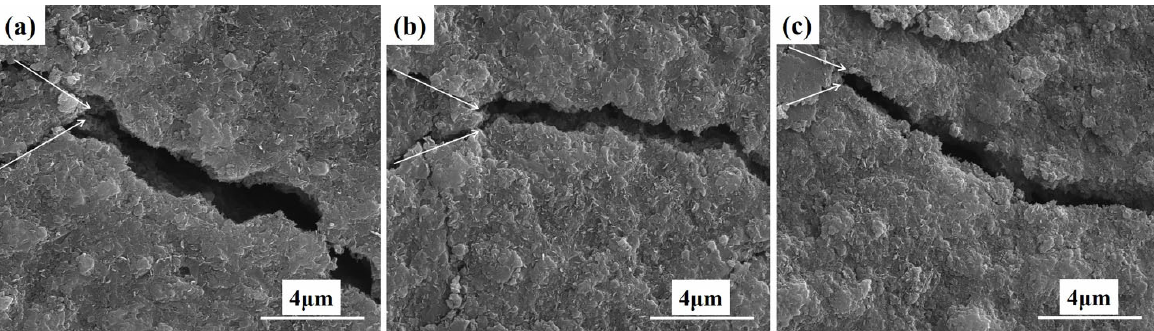
Fig. 2 TEM microstructures of Si 2 BC 3 N ceramics: (a) T0, (b, c) T1, and (d, e) T3.